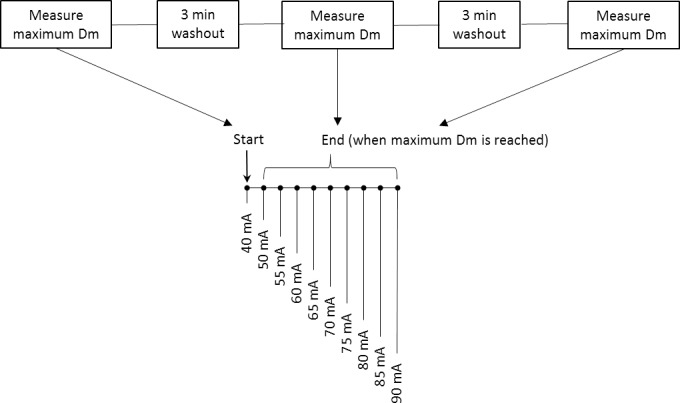
Experiment 1 timeline.The reliability of stimulus amplitude needed for maximum Dm. Tensiomyography measures are ceased when Dm is achieved. Stimulations are delivered at 1-minute intervals.